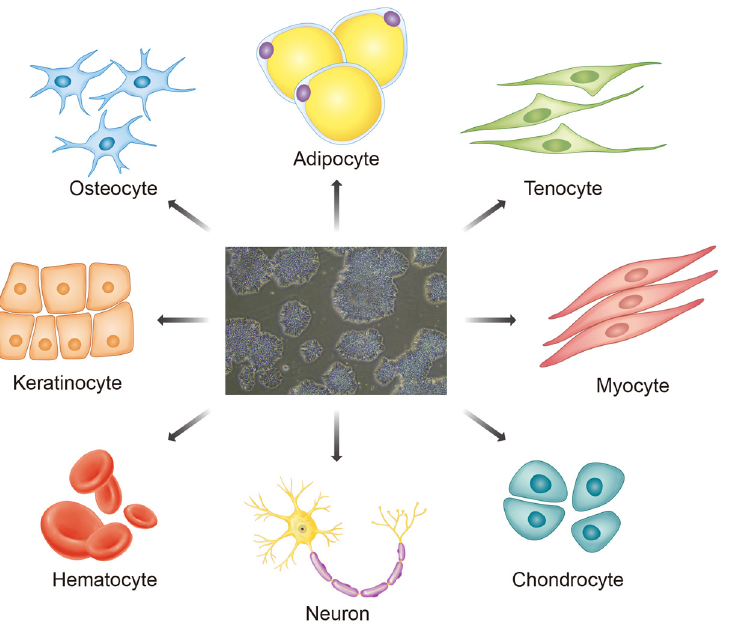
Figure 1. The differentiation potential of pluripotent stem cells, specifically iPSCs. Once the somatic cells are reprogrammed into iPSCs, they can be differentiated into any type of adult cell in the human body, as shown above. These iPSCs can then be used for different clinical purposes.